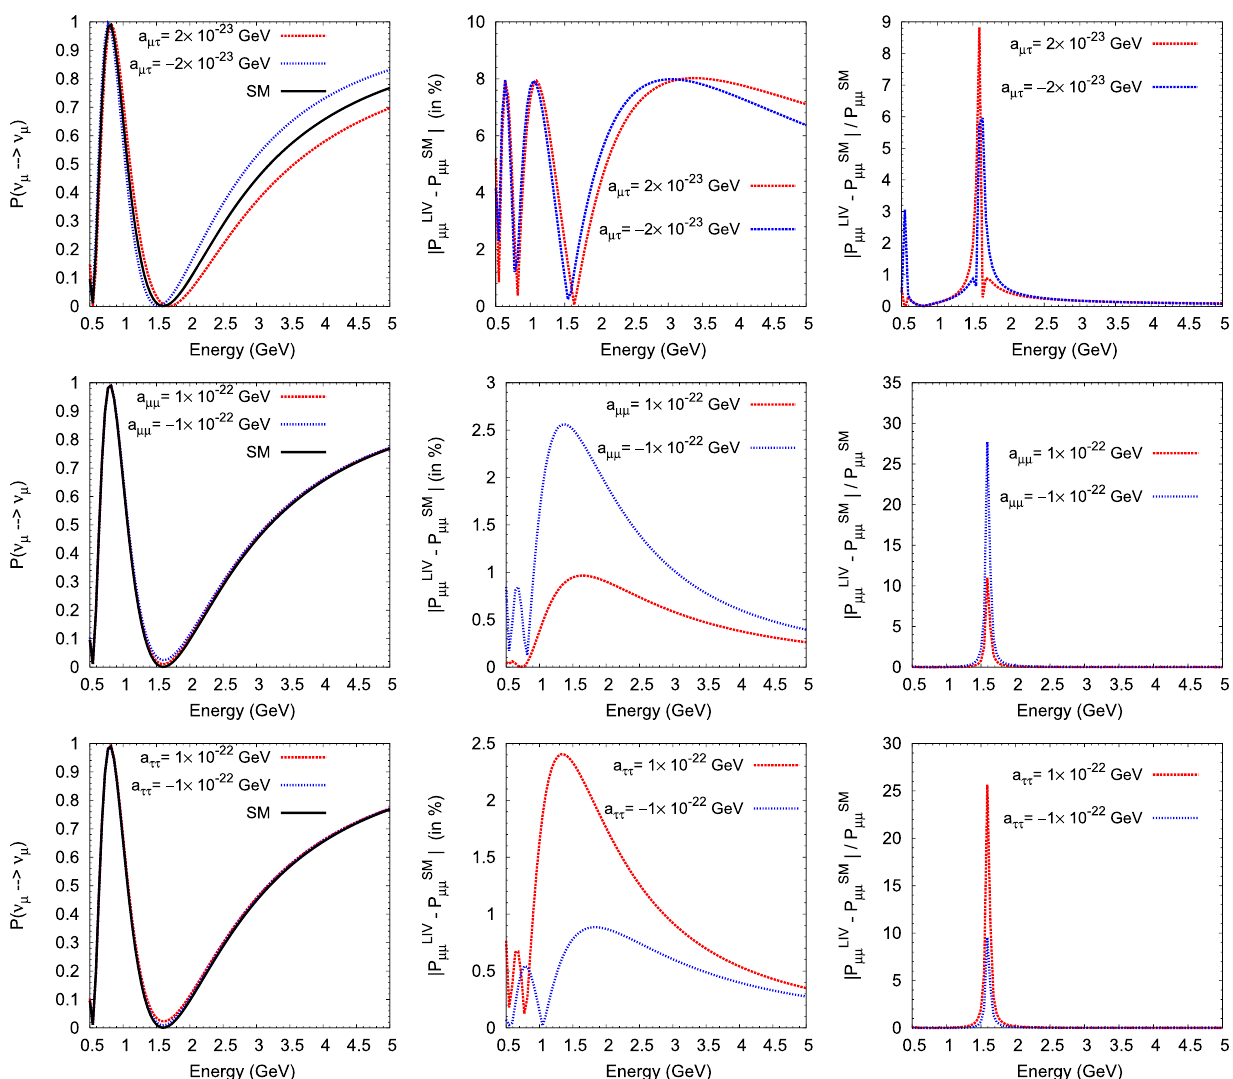
Fig. 2 Same as Fig. 1 for the ν μ survival probabilities as a function of neutrino energy in presence of a μμ , a μτ , and a ττ LIV parameters for NO ν A